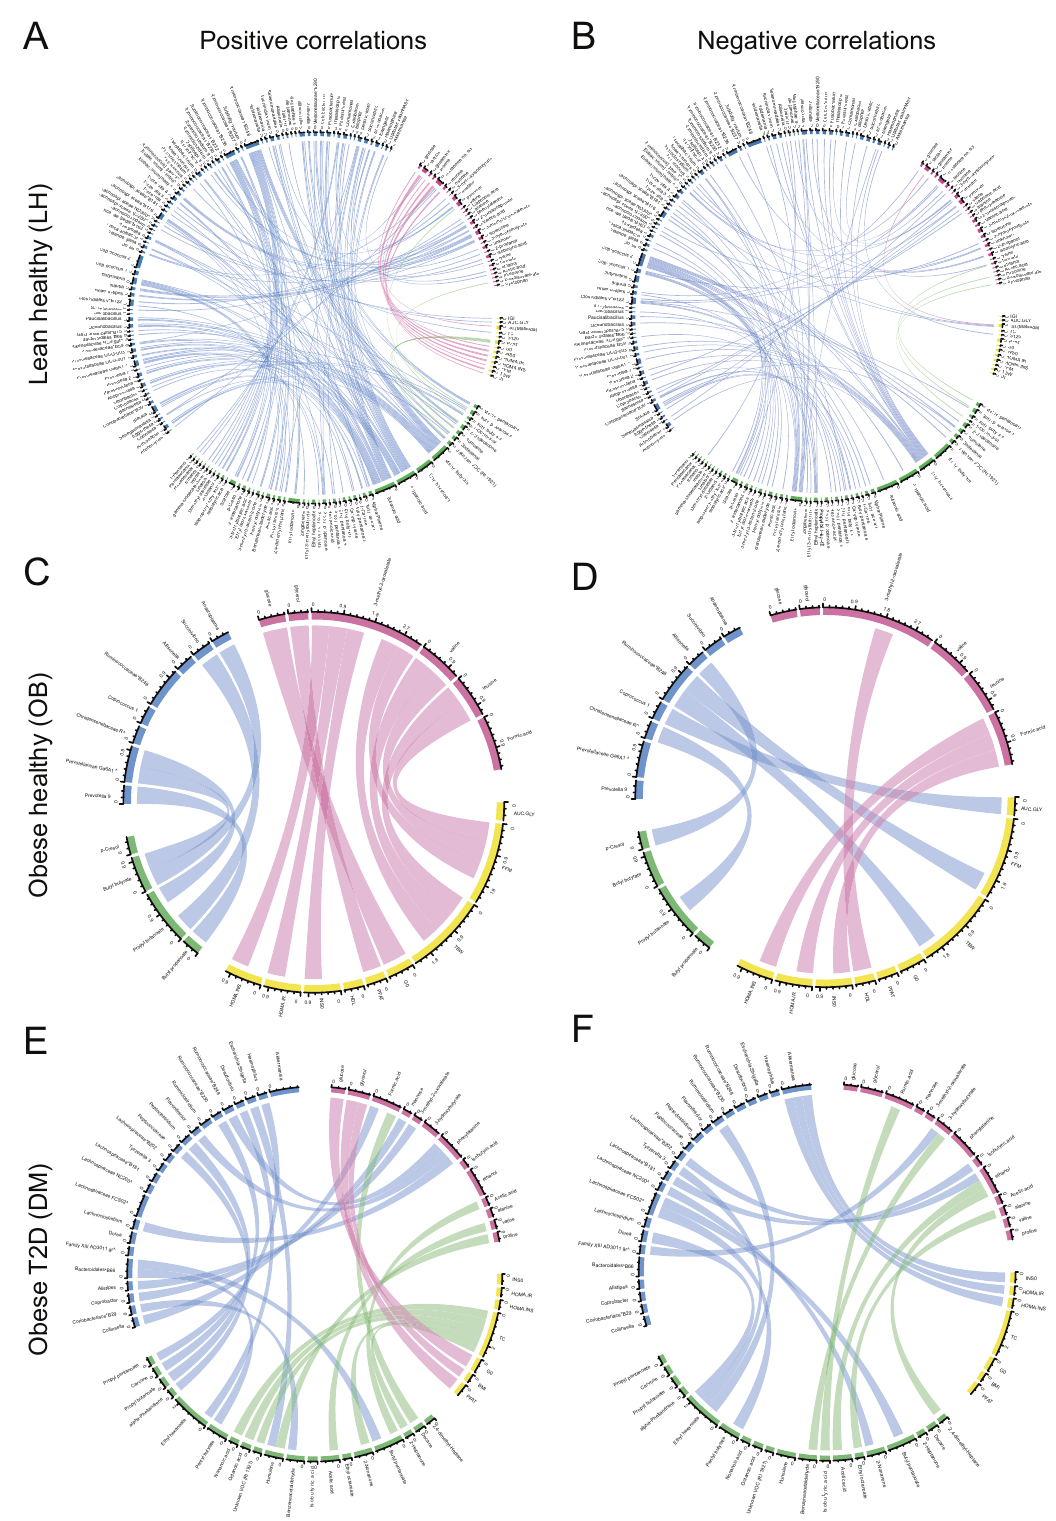
Fig. 4 Correlation chord diagrams between variables of different datasets. Spearman correlations were calculated for each group (LH, OB, DM) separately. Only correlations among variables from different datasets (clinical variables, microbiome, serum, and fecal metabolome) and characterized by | ρ | > 0.5 are presented. Positive ( A , C , E ) and negative ( B , D , F ) correlations are shown separately. The colors on the circuit code individual datasets, the color of the edges corresponds to one of the datasets that are linked by the edge. Blue: microbiome; green: fecal metabolome; yellow: clinical variables; violet: serum